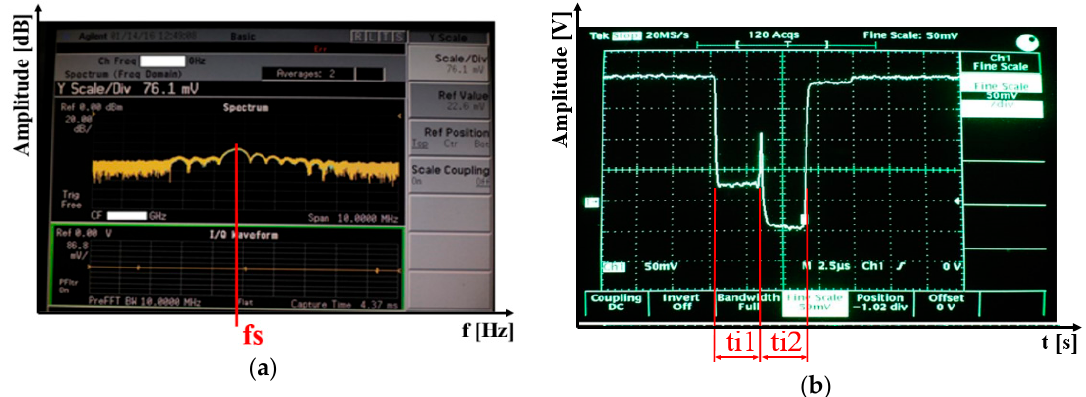
Figure 20. Signal detected ( a ) in the frequency field; ( b ) in the time field.